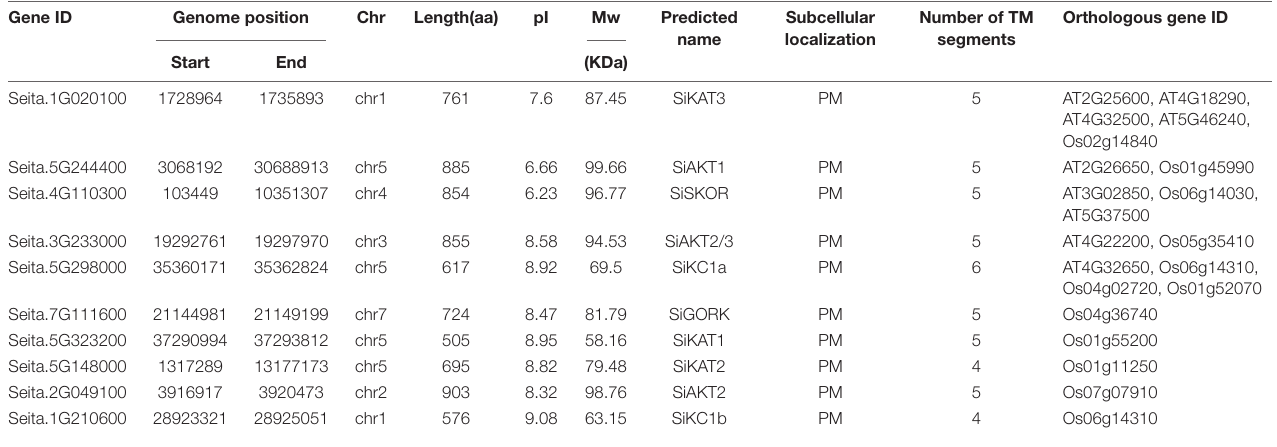
TABLE 1 | Detailed information of predicted Shaker K + channel genes in foxtail